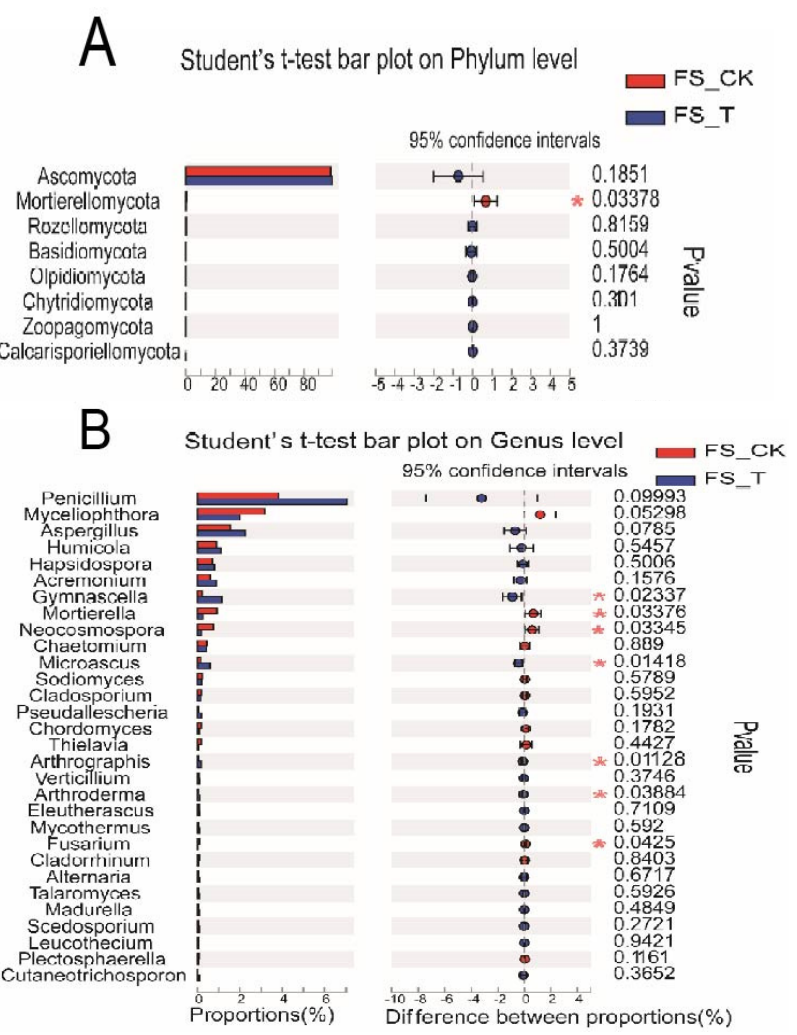
Figure 11. Changes in the relative abundance of fungal ( A ) phyla and ( B ) genera in triple-fumigated soil that had been used to produce tomatoes. ‘Triple fumigation’ refers to the simultaneous application of chloropicrin, dimethyl disulfide and metham sodium. The t -test reported the statistical differences (asterisked, * 0.01 < p ≤ 0.05) between the means of three replicates within the phylum or genus levels.